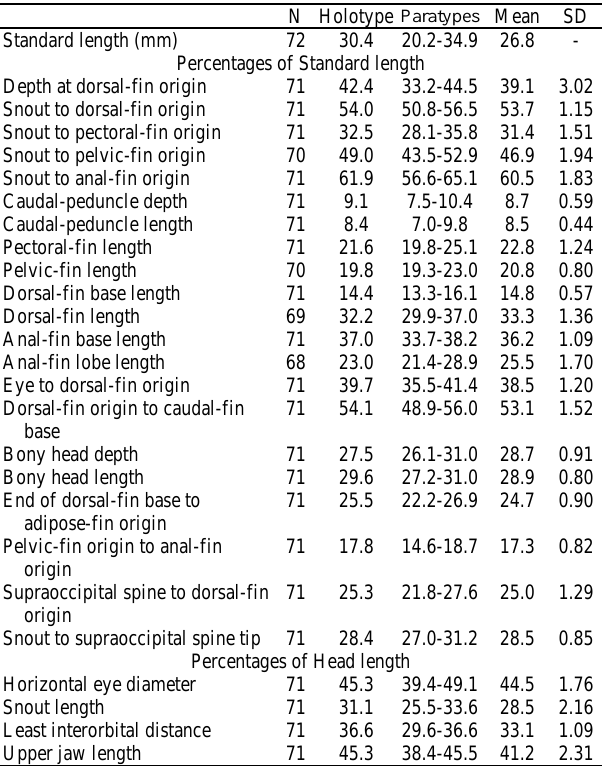
Table 1. Morphometric data of Hemigrammus machadoi , new species, based on holotype and paratypes. N = Number of specimens, and SD = standard deviation.